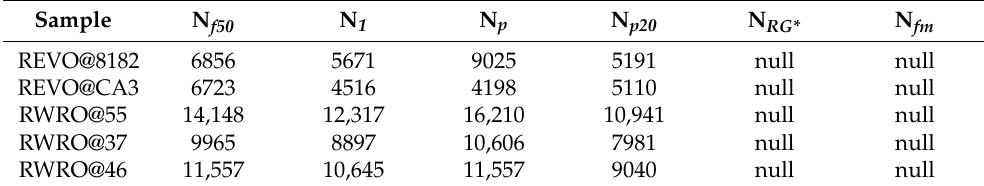
Table 9. Fatigue life of rejuvenated asphalt (6.5%